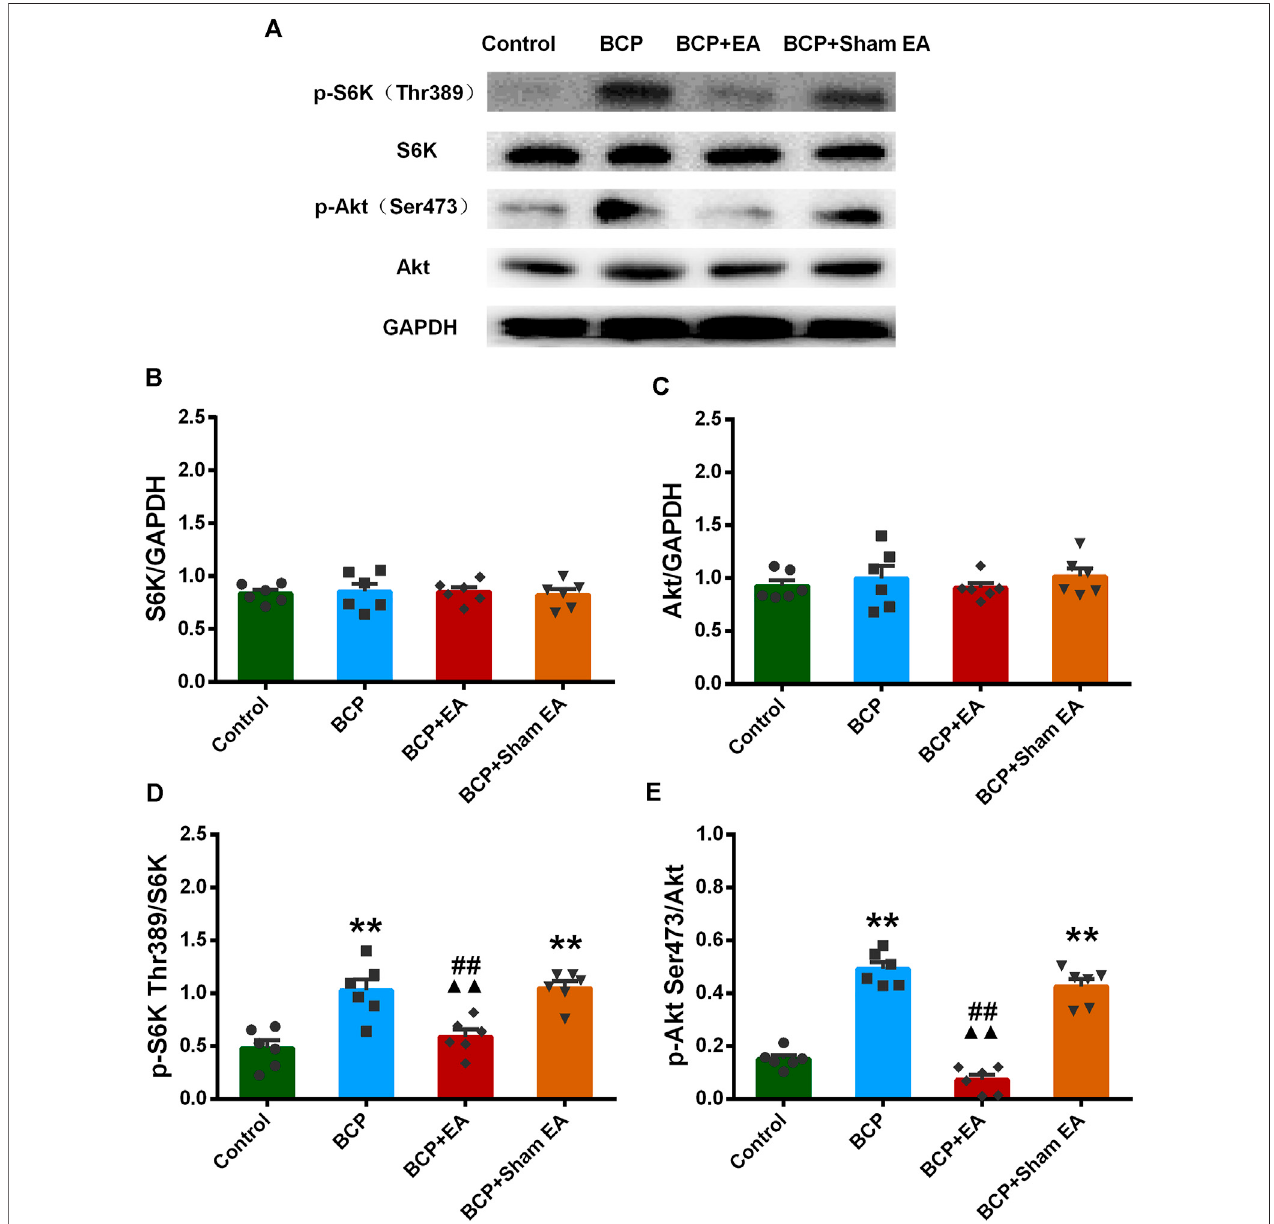
FIGURE 7 | Regulation effects of EA on the phosphorylation of S6K and Akt. (A) The representative WB band; (B) the expression of S6K total protein, N (cid:2) 6 rats/ group; (C) the expression of Akt total protein, N (cid:2) 6 rats/group; (D) the expression of p-S6K Thr389, N (cid:2) 6 rats/group; (E) the expression of p-Akt Ser473, N (cid:2) 6 rats/ group. * p < 0.05, ** p < 0.01, compared with the control group; ▲▲ p < 0.01, compared with the BCP group; ## p < 0.01, compared with the BCP + sham EA group.